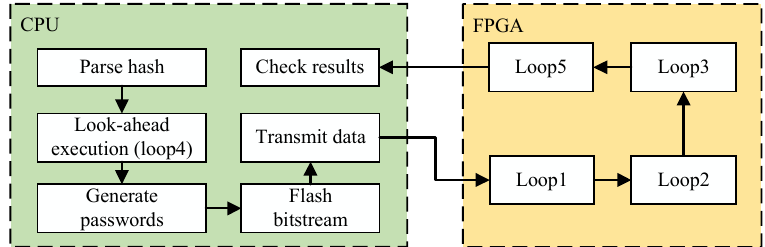
Figure 6: Flow chart of sha256crypt password recovery on the proposed